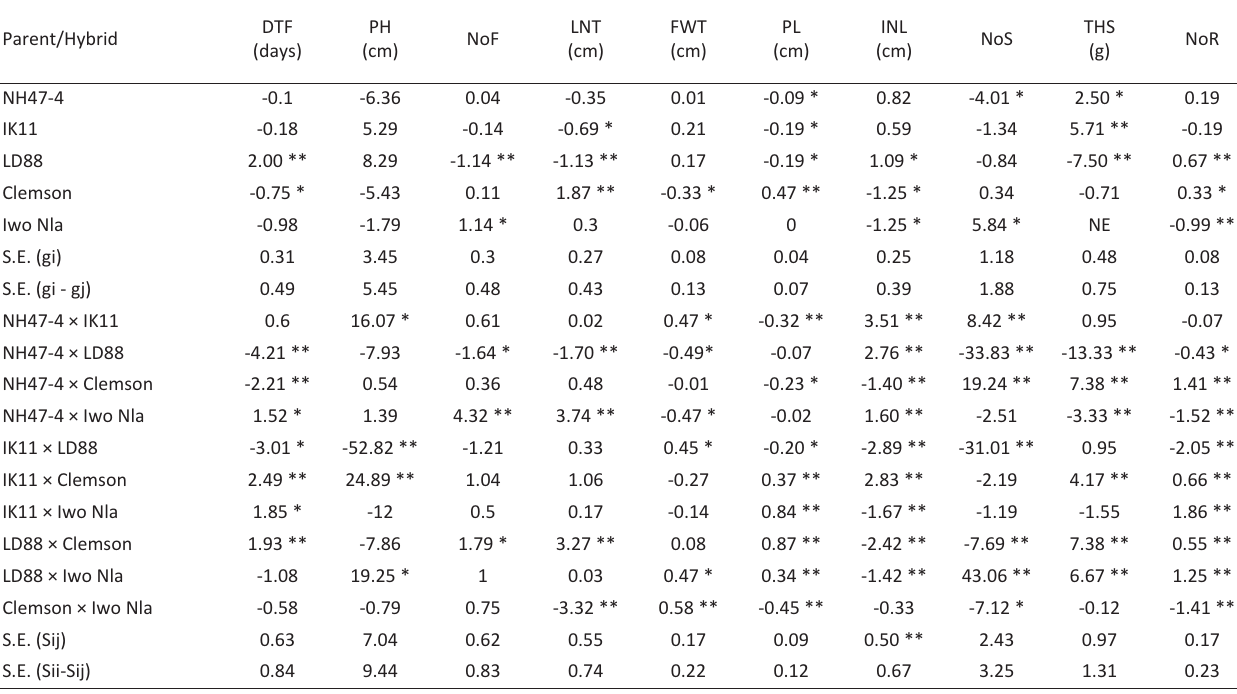
Table 3 ­ Estimates of general (GCA) and specific combining ability (SCA) effects of okra parents and hybrids respectively for measured